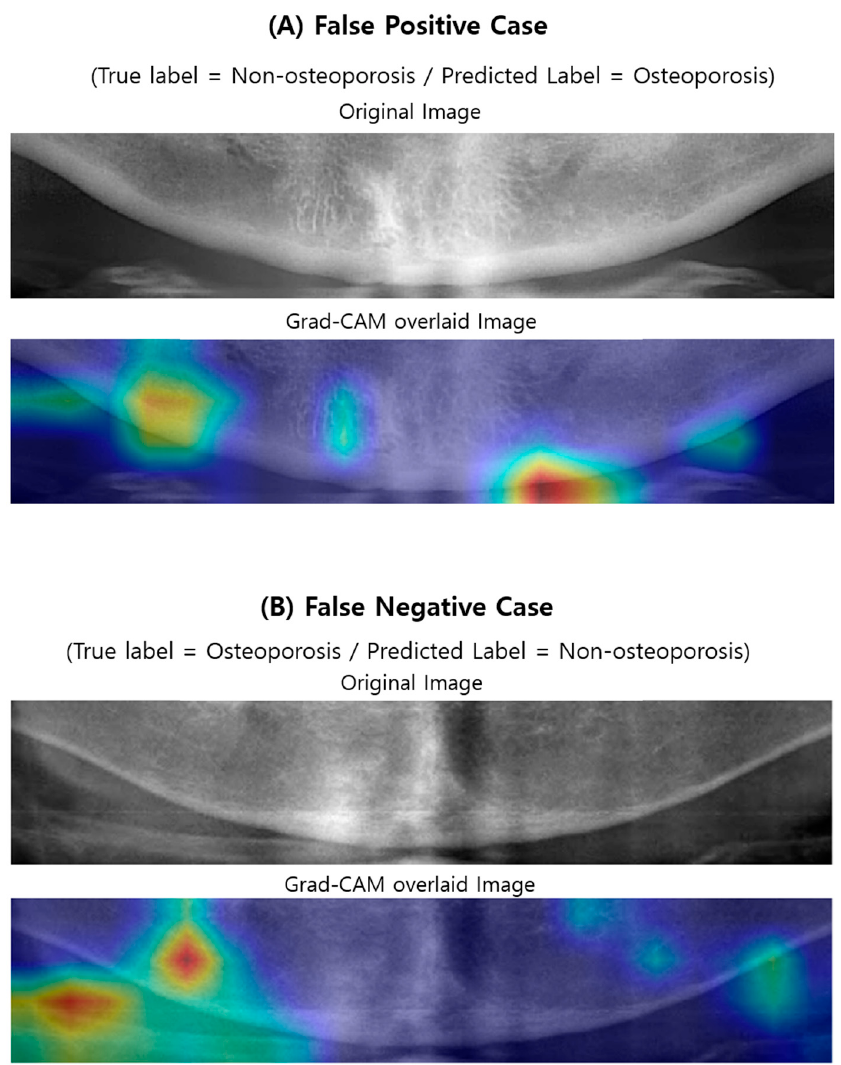
Figure 6. Original and Grad-CAM sample images of incorrectly predicted by the best-performing deep CNN model (VGG16-TR-TF) for DPR image-based osteoporosis screening are illustrated. Below each original sample images, a Grad-CAM image is superimposed over the original image. The bright red in each Grad-CAM image indicate the region that has the greatest impact on screening osteoporosis patients.